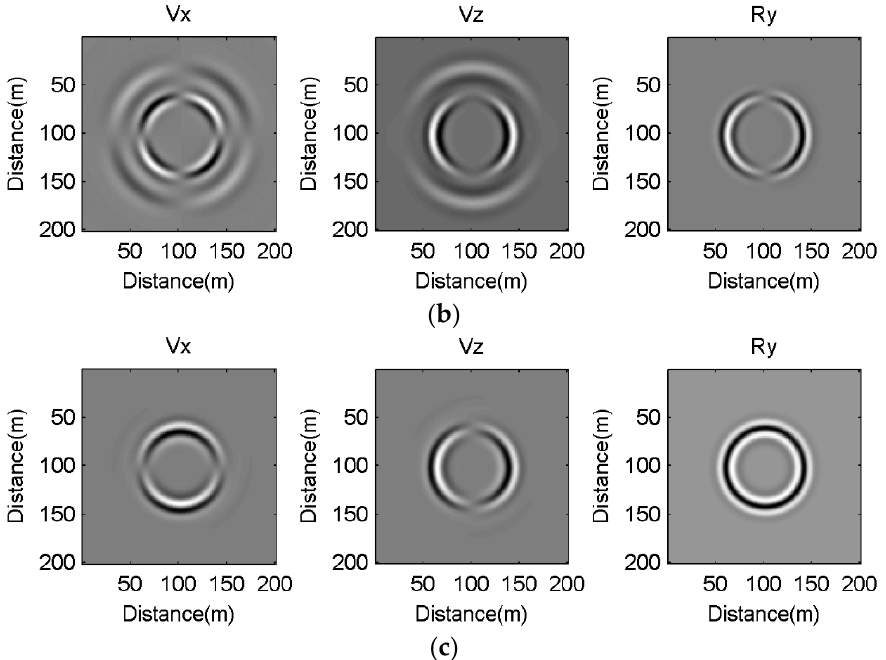
Figure 4. Snapshots of wave fields at 0.05 s. ( a ) Radial concentrated force source. ( b ) Vertical concentrated force source. ( c ) Shear source.